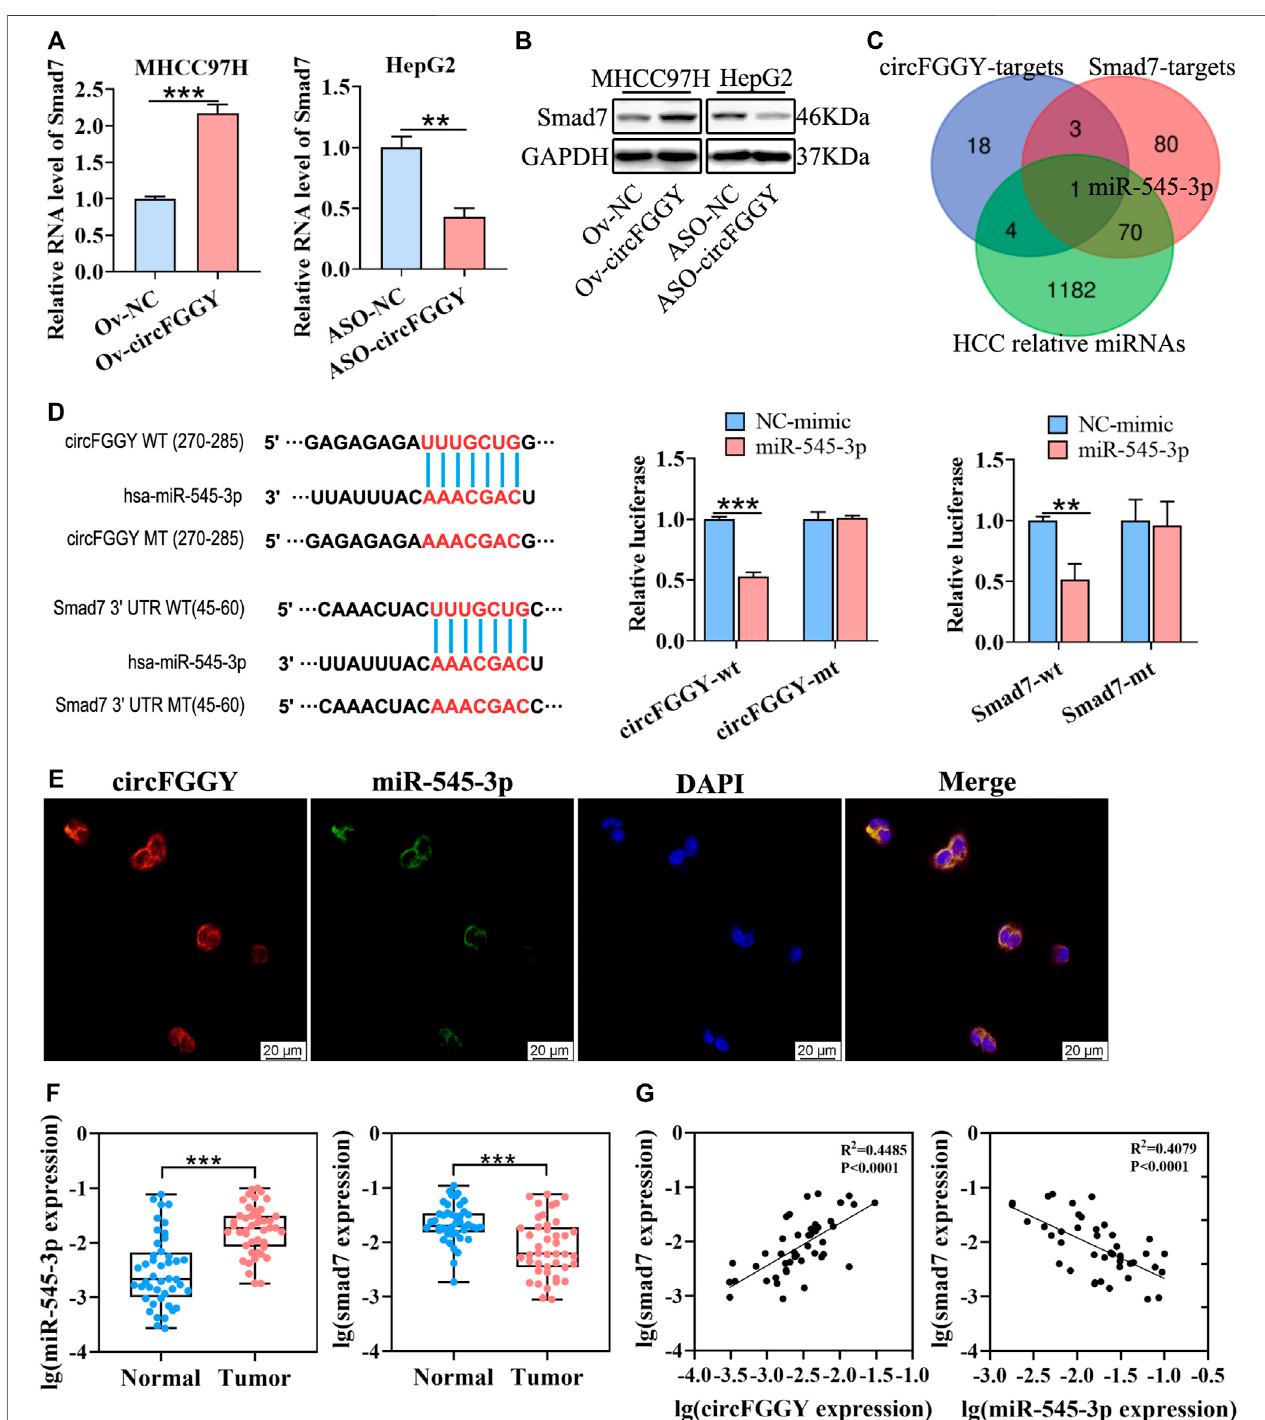
FIGURE4| CircFGGYpromotestheexpressionofSmad7bycompetitivelytargetingmiR-545-3p. (A,B) qRT-PCRandWesternblotdetectedtheRNAandprotein expression of Smad7 in MHCC97H cells transfected with circFGGY overexpression vector and HepG2 cells transfected with ASO-circFGGY. (A) : data were shown as mean ± SD, n = 3. ** p < 0.01, *** p < 0.001 in independent Student ’ s t test. (C) Venn diagram showing potential miRNA targets for circFGGY and SMAD7. The miRNA targets for circFGGY were obtained from circbank database. The miRNA targets for Smad7 were obtained from targetscan and miRDB database. The HCC associated miRNAs were obtained from MNDR database. (D) The luciferase activity of the wild-type or mutant circFGGY/Smad7 after co-transfection with miR-545-3p mimicsorNC-mimicsinMHCC97Hcells.Datawereshownasmean±SD, n =3.** p < 0.01,*** p < 0.001inindependentStudent ’ sttest.Wt,wild-type;mt,mutant. (E) In situ hybridization assay showing colocalization of endogenously expressed circFGGY and miR-545-3p in the cytoplasm. The circFGGY probes were labeled with cy3. The miR-545-3p probes were labeled with FITC. Nuclei were stained with DAPI. Scale bar, 20 µm. (F) qRT-PCR detected the RNA expression of miR-545-3p and Smad7 in the 50 paired HCC and adjacent normal tissues. Wilcoxon matched-pairs signed rank test was used. Data represented as median (Min, Max), n = 50. ***: p < 0.001. (G) Pearson correlation analysis between RNA expression of Smad7 and circFGGY/miR-545-3p in clinical tumor tissues. n = 50.